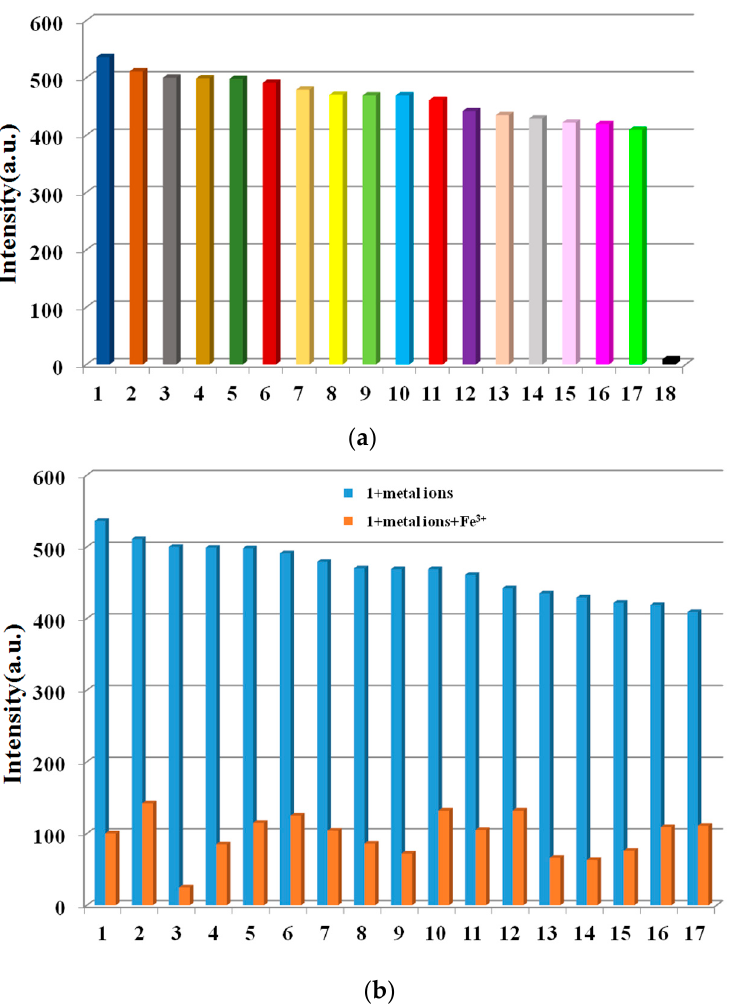
Figure 4. Fluorescence intensity map of ( a ) complex 1 (1.5 mg) dispersed in aqueous solutions of multifarious metal ions (3 mL, 10 − 3 M) under the excitation of 275 nm and ( b ) with subsequent addition of Fe 3+ . (1) Zn 2+ , (2) Ni 2+ , (3) Mn 2+ , (4) Cr 3+ , (5) Na + , (6) Co 2+ , (7) Ba 2+ , (8) Pb 2+ , (9) Sr 2+ , (10) Cd 2+ , (11) Cu 2+ , (12) Ca 2+ , (13) K + , (14) Bi 2+ , (15) Mg 2+ , (16) Ag + , (17) Hg 2+ , and (18) Fe 3+